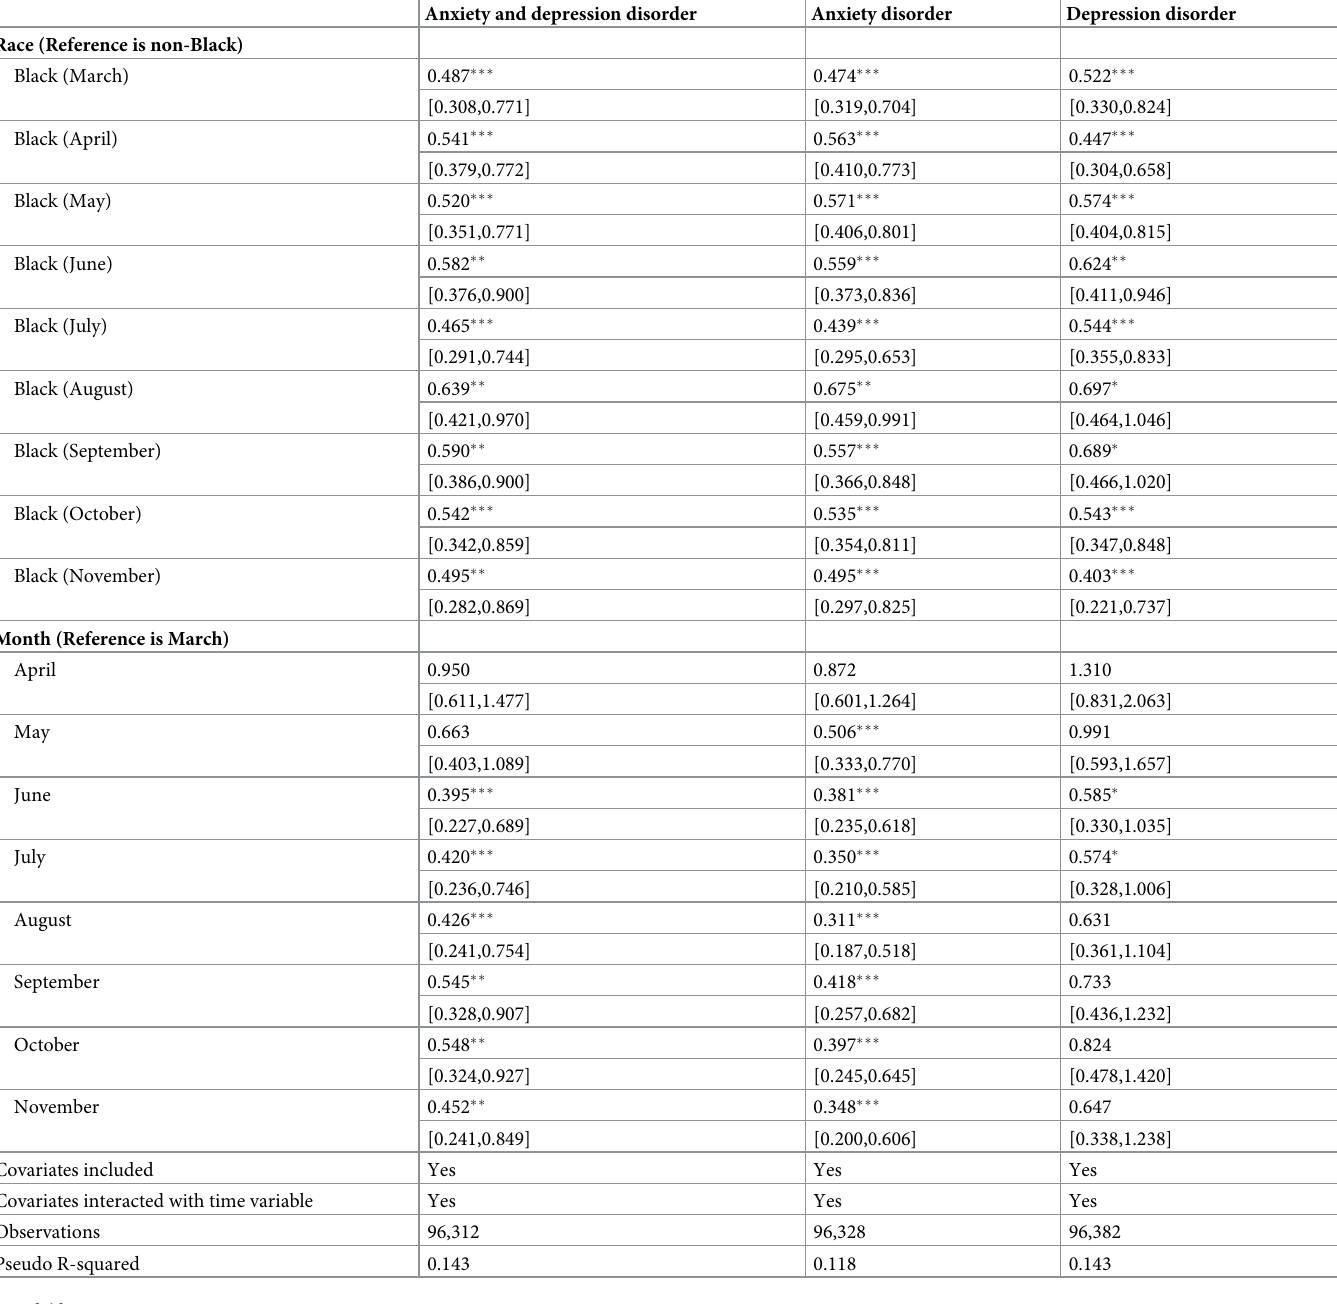
Table 4. Adjusted odds ratios; cross-sectional analysis (Wave 1 data: March 10, 2020–March 30, 2020); outcome variables: Reporting symptoms for anxiety and depression (Column 1), anxiety (Column 2), and depression (Column